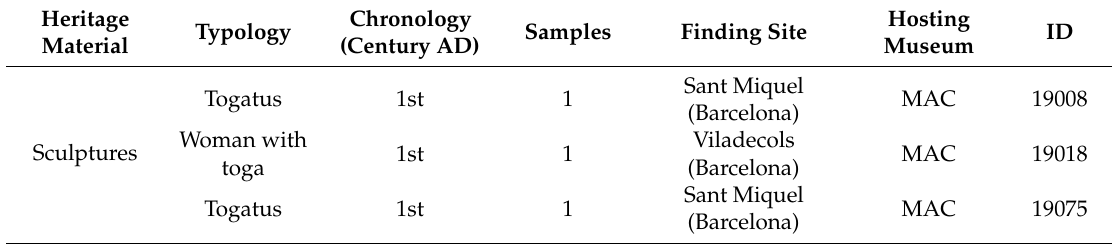
Table 1. Summary of the retrieved samples from the studied heritage